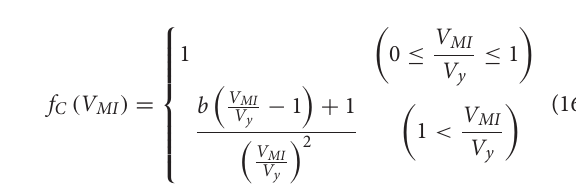
FIGURE 13 | Total input energy, hysteretic energy, and damping energy of Models 1, 2, and 3 under critical multi impulse and corresponding sinusoidal wave. (A) Model 1, (B) Model 2, (C) Model 3.